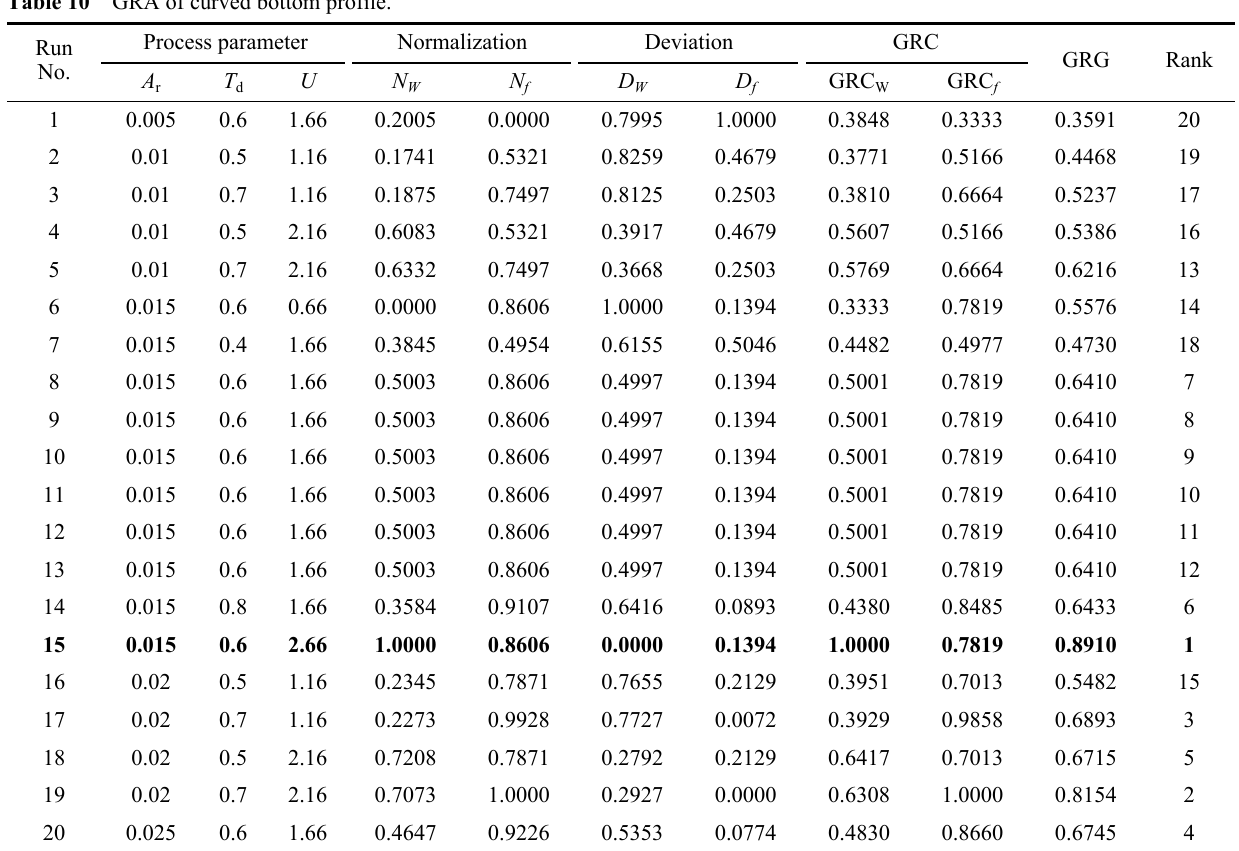
Table 10 GRA of curved bottom